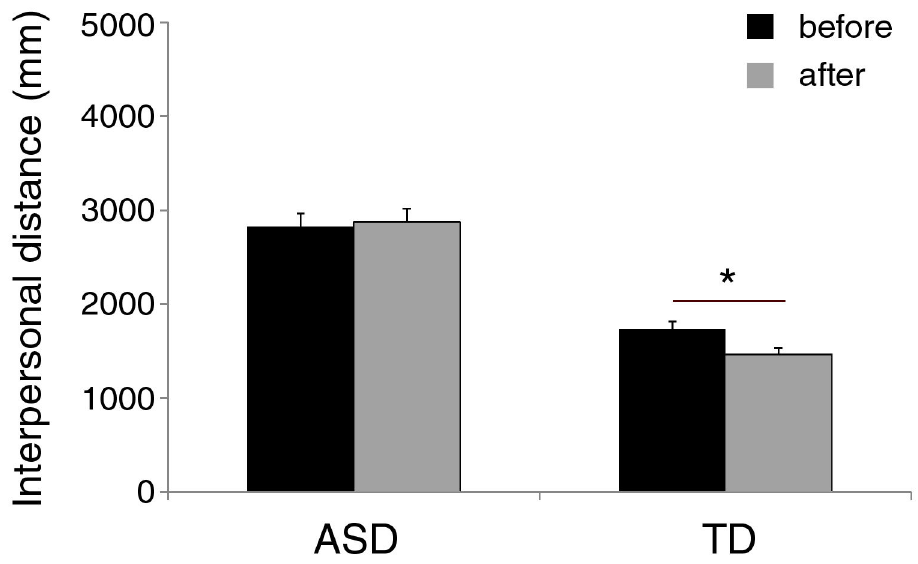
Figure 3. Mean preferred distance from the confederate before and after a brief social interaction in children with typical development (TD), and children with Autism Spectrum Disorder (ASD). Asterisk indicates significant comparison (p < 0.05). Error bars denote